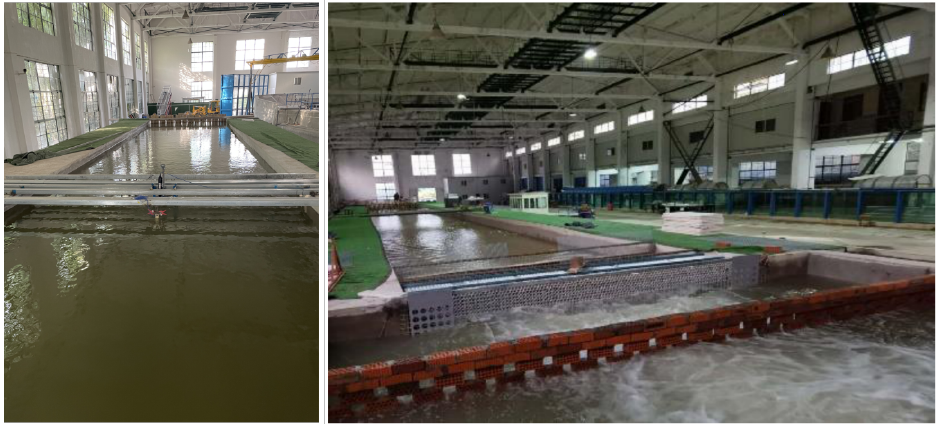
Figure 1. Experimental setup at the circulating flow flume. The left picture shows the movable platform on which the Nortek Vectrino Profiler is positioned. The right picture shows the porous walls at the inlet of the